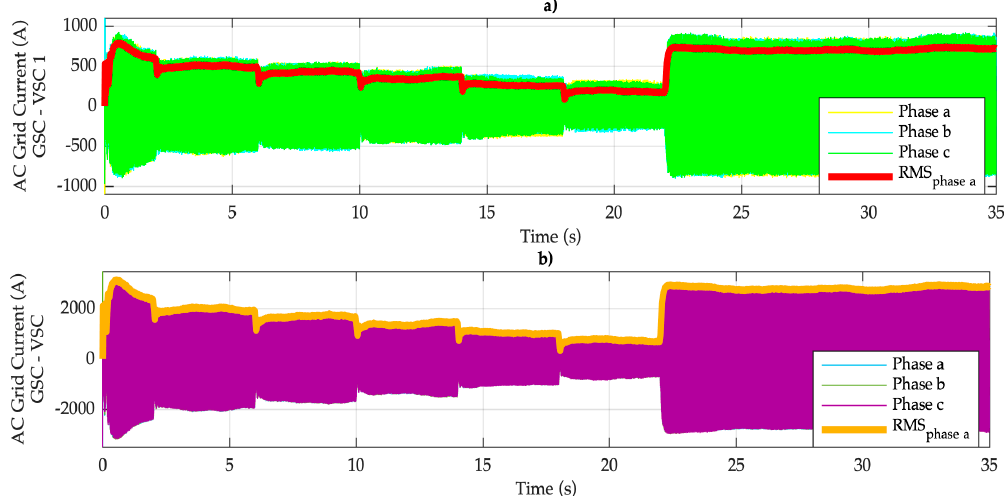
Figure 8. Injection / absorption of current by the grid-side converter (GSC) formed by four (VSCs) connected in parallel in the distribution grid. ( a ) Current handled by VSC 1; ( b ) total current handled by the GSC.